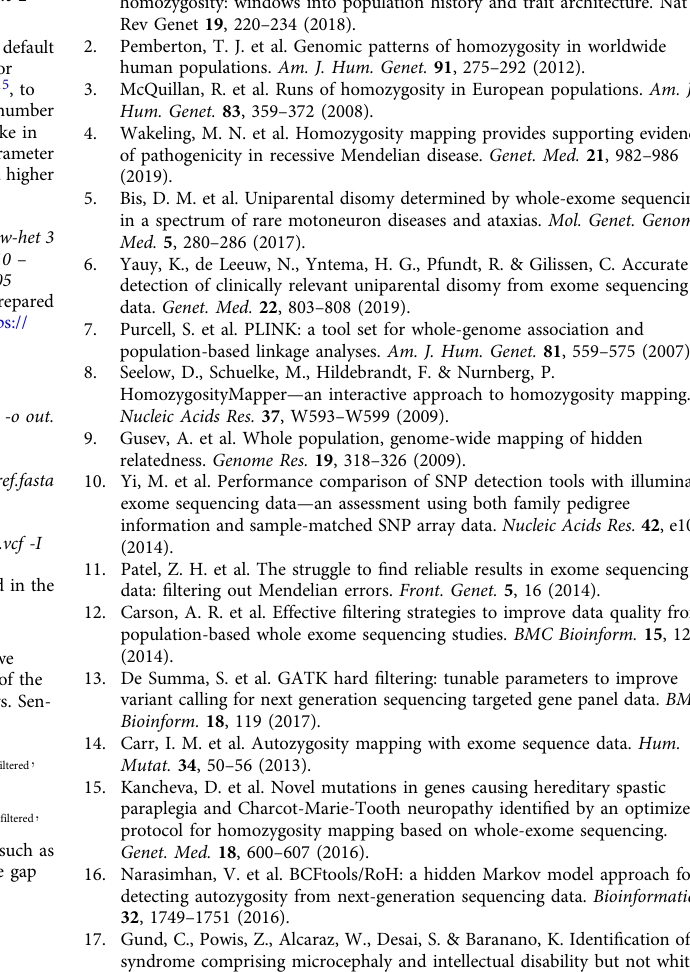
table in UCSC Table Browser (https://genome.ucsc.edu/cgi-bin/hgTables). F -score was also added as a measure of accuracy, computed as: F (cid:2) score ¼ 2 (cid:3) sensitivity (cid:3) specificity = sensitivity þ specificity